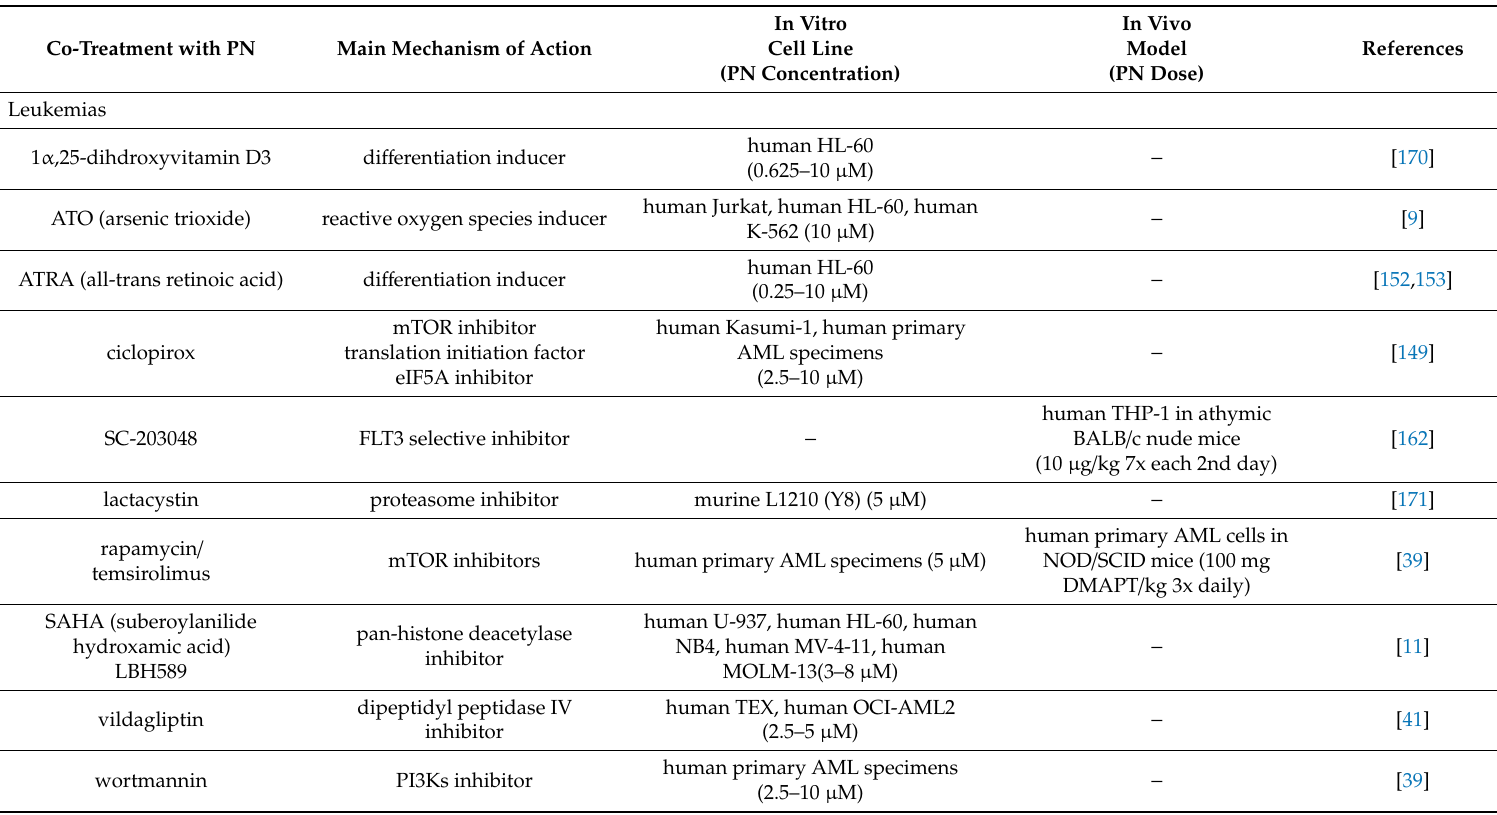
Table 1. Chemotherapeutics investigated in combination with parthenolide (PN) and its derivatives in di ff erent types of cancer. Co-Treatment with